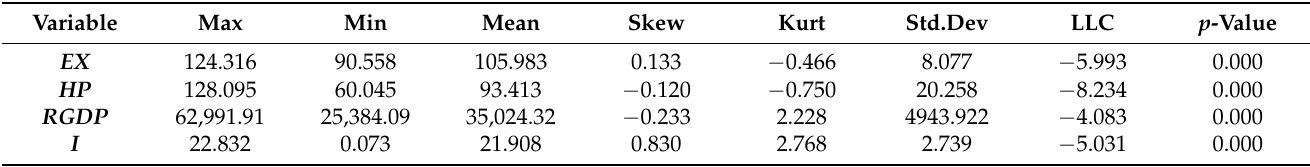
Table 3. The LLC panel unit root test results.